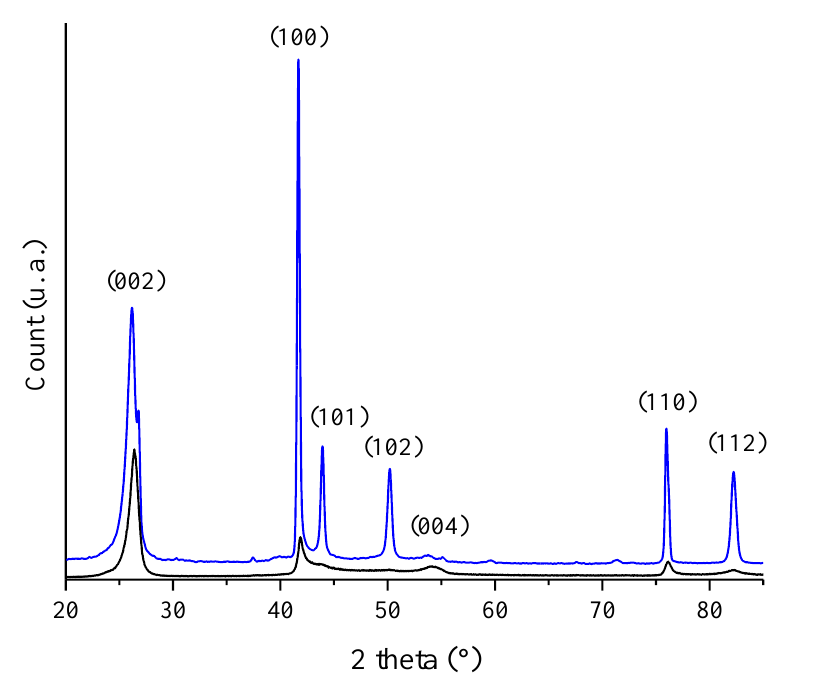
Figure 9. XRD patterns of monolithic BN prepared following the strategies 1 (warm-pressing of PB60 → pyrolysis, black curve) and 2 (spray-pyrolysis of borazine → hot-pressing, blue curve). ( 100 )